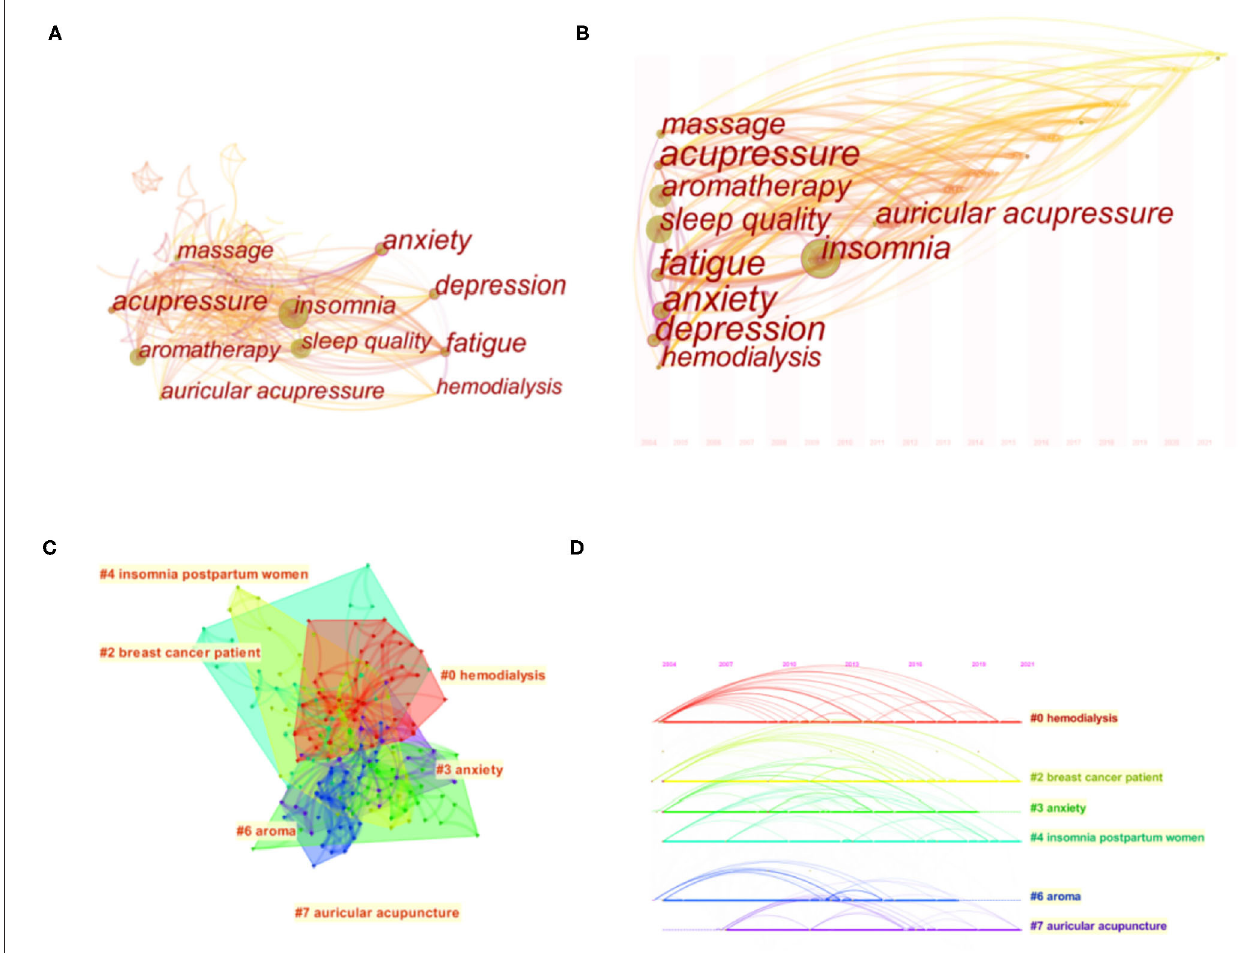
FIGURE 7 | Network map (A) , timezone view (B) , cluster map (C) and timeline (D) of the keywords.